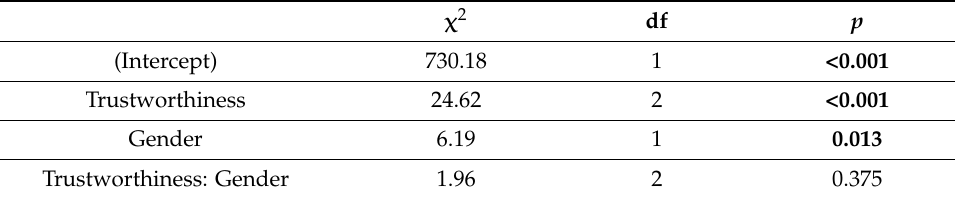
Table 2. Results of Wald χ 2 test for the lmm on the k parameter. df = degree of freedom. Significant p values are reported in bold.